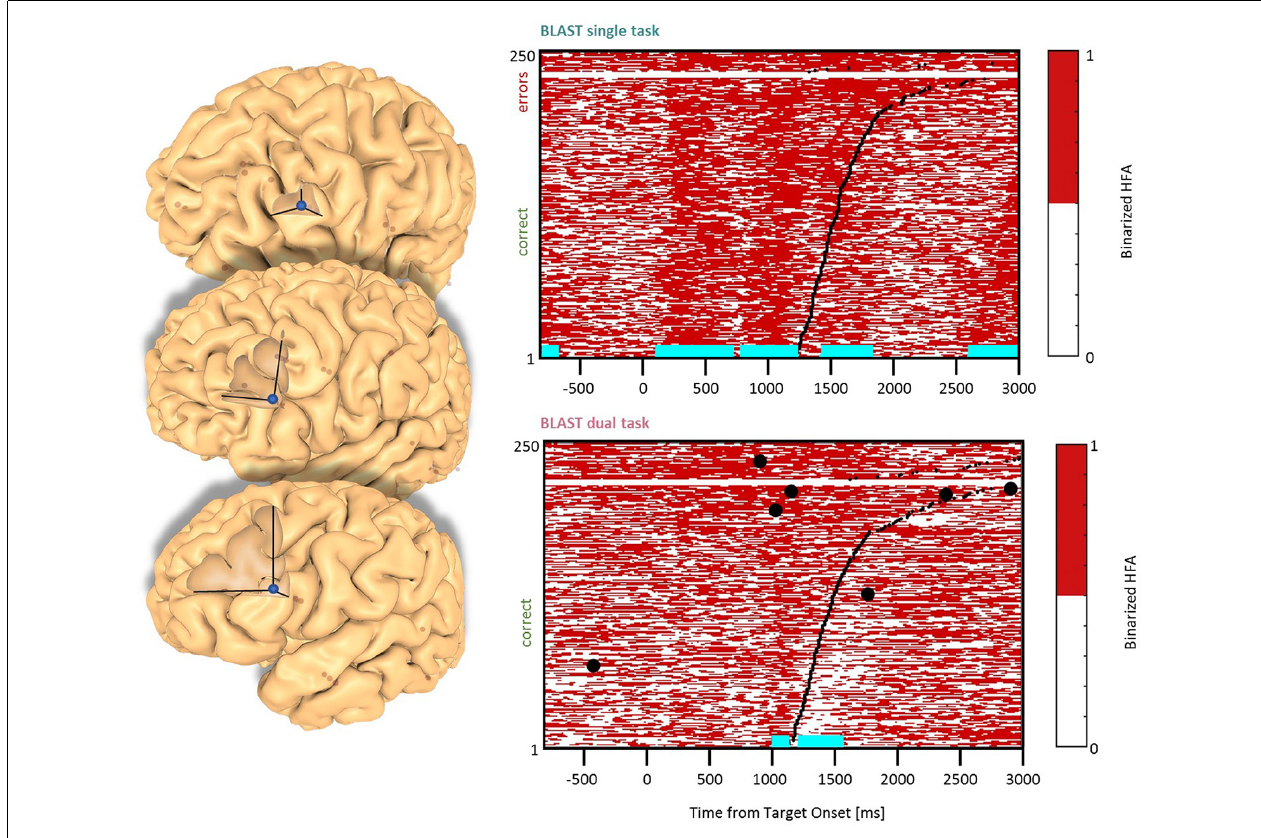
FIGURE 4 | Interference in the Inferior Frontal Gyrus/Sulcus. Sites with interference between T1 and T2 are displayed at their precise anatomical location onto a 3D representation of the participant’s brain. The matrix representation reproduces the display of Figure 2 , for the single-task and dual-task conditions for one of the sites. Patients id [Px] and iEEG site names, from left to right and top to bottom: G’13 [P4]; K’10 [P5] (matrix displayed); Q’2